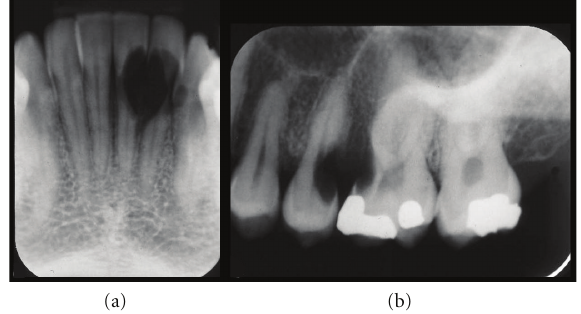
Figure 7: Patient 2: radiographs demonstrating regional aggressive root resorption in the left mandibular incisors (a) and in the left maxillary second premolar and first molar (b).